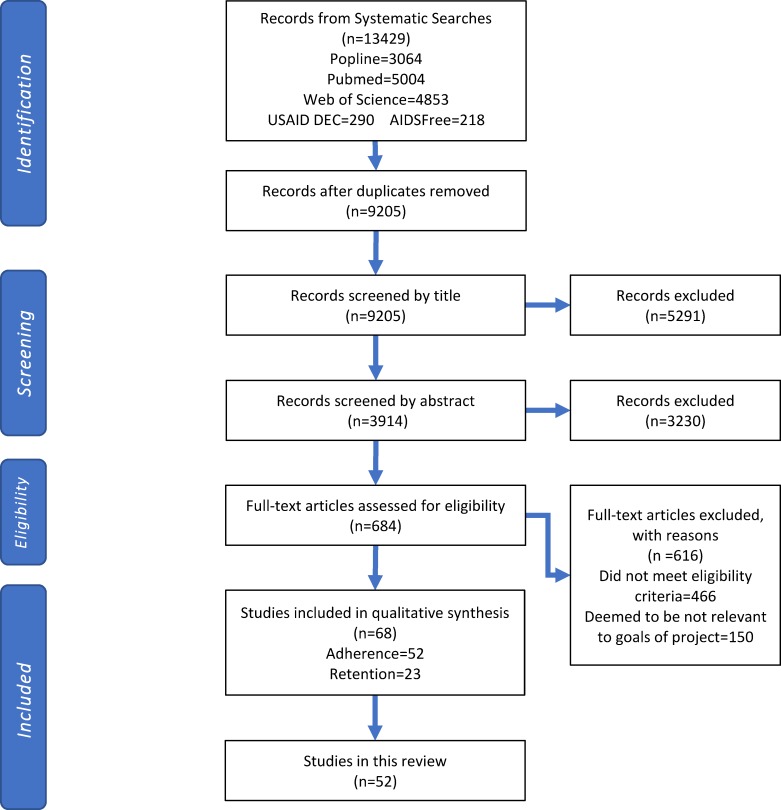
Selection process for inclusion of studies.